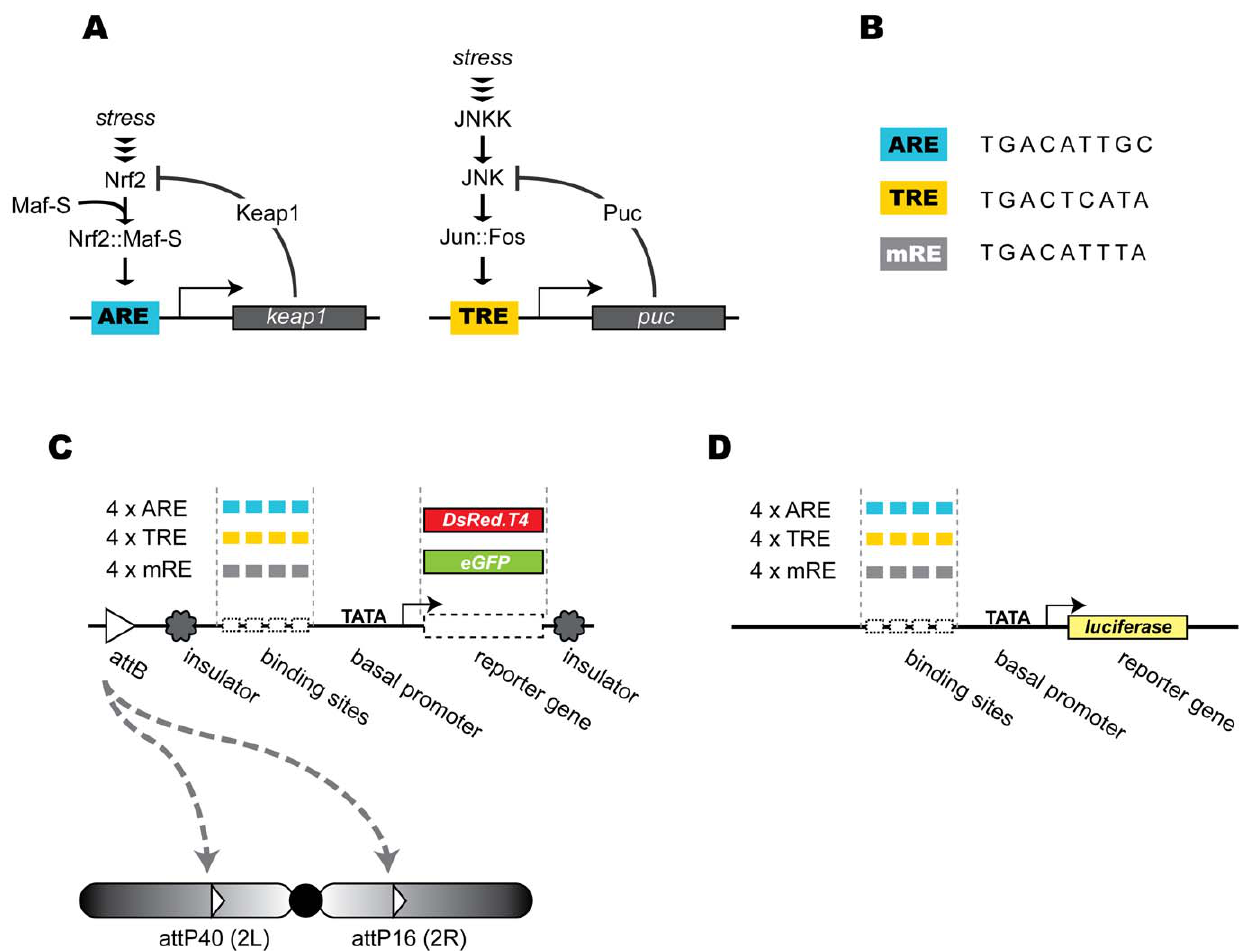
Figure 1. Design of ARE and TRE reporter genes. A. Simplified cartoons of stress signaling by the Nrf2 and JNK signaling pathways. Upon exposure to stress or cancer chemopreventive drugs, Nrf2 is relieved from repression by its cognate inhibitor Keap1. Nrf2 then dimerizes with Maf-S and binds to AREs of its target genes to activate their transcription. Activation of the keap1 gene itself by Nrf2 engages a negative feedback loop that limits Nrf2 responses. The JNK cascade with the stress inducible JNKK and JNK activates the Jun::Fos dimer by phosphorylation. This leads to the activation of genes via Fos::Jun binding sites or TREs. Activation of the gene encoding the JNK phosphatase, Puckered causes negative feedback regulation. B. Sequence of the artificial TRE and ARE elements used for the construction of the Nrf2 and JNK reporters. The sequences correspond to optimal CncC/Maf and Jun/Fos binding sites as reported by Kerppola and Curran [29]. A mutant version of the response elements (mRE) that does not bind either Jun/Fos or Nrf2/Maf dimers was generated as a control construct. C. Modular design of in vivo reporter constructs. Each transgenic cassette carries an attB site for W C31 recombinase-catalyzed genomic integration, a minimal heat shock protein 70 (Hsp70) promoter (TATA) and eGFP or DsRed.T4 reporter gene driven by four head-to-tail concatenated copies of the ARE, TRE or mRE elements. The promoter-reporter cassettes are flanked by gypsy insulators to prevent ‘position effects’ of surrounding chromatin. Transgenic flies carry reporter transgenes at predetermined locations, attP 16 on the right arm of chromosome 2 and attP 40 on the left arm of the same chromosome. D. Design of reporters for cell culture experiments. In a similar design as shown in C, the firefly luciferase reporter gene was placed under a minimal heat shock protein 70 (Hsp70) promoter (TATA) and four head-to-tail concatenated copies of the ARE, TRE or mRE